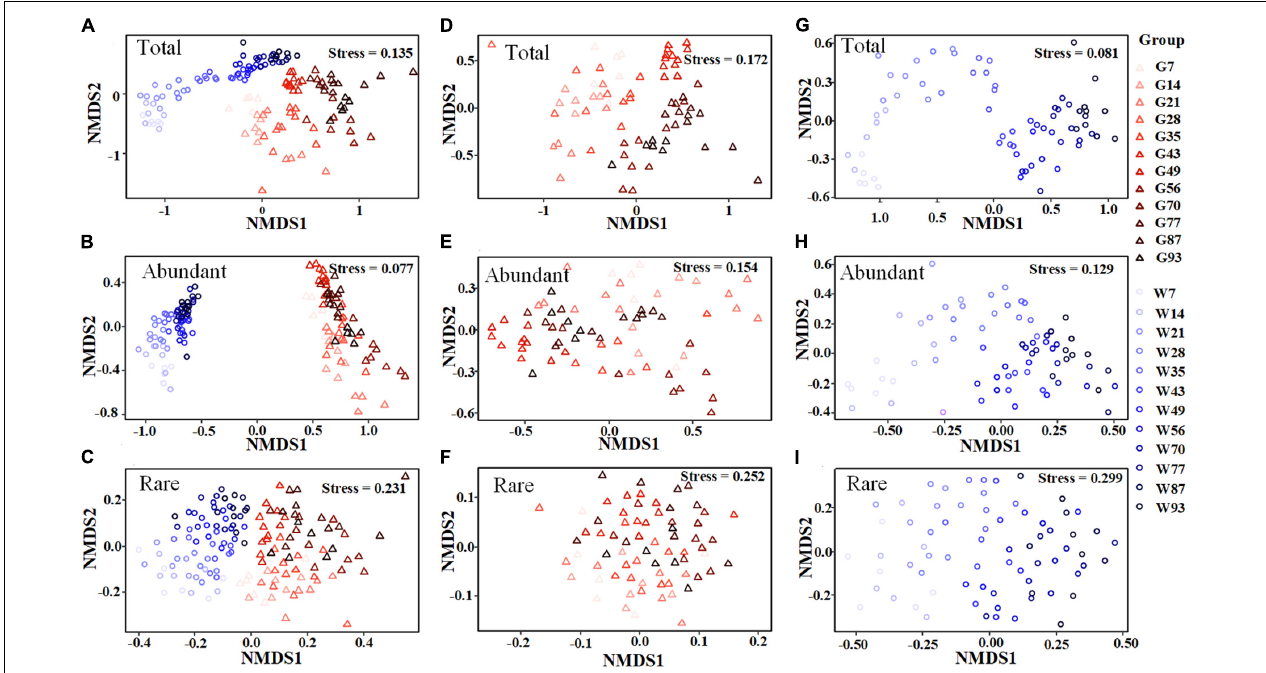
FIGURE 1 | Non-metric multidimensional scaling (NMDS) ordinations showing the structures of total, abundant and rare communities. NMDS ordination of the total, abundant, and rare bacterial communities in both the shrimp gut and rearing water (A–C) , shrimp gut (D–F) , rearing water (G–I) based on Bray-Curtis similarity, respectively. Samples were coded and colored by habitat and shrimp life stage, of which G and W indicate shrimp gut and water, respectively.